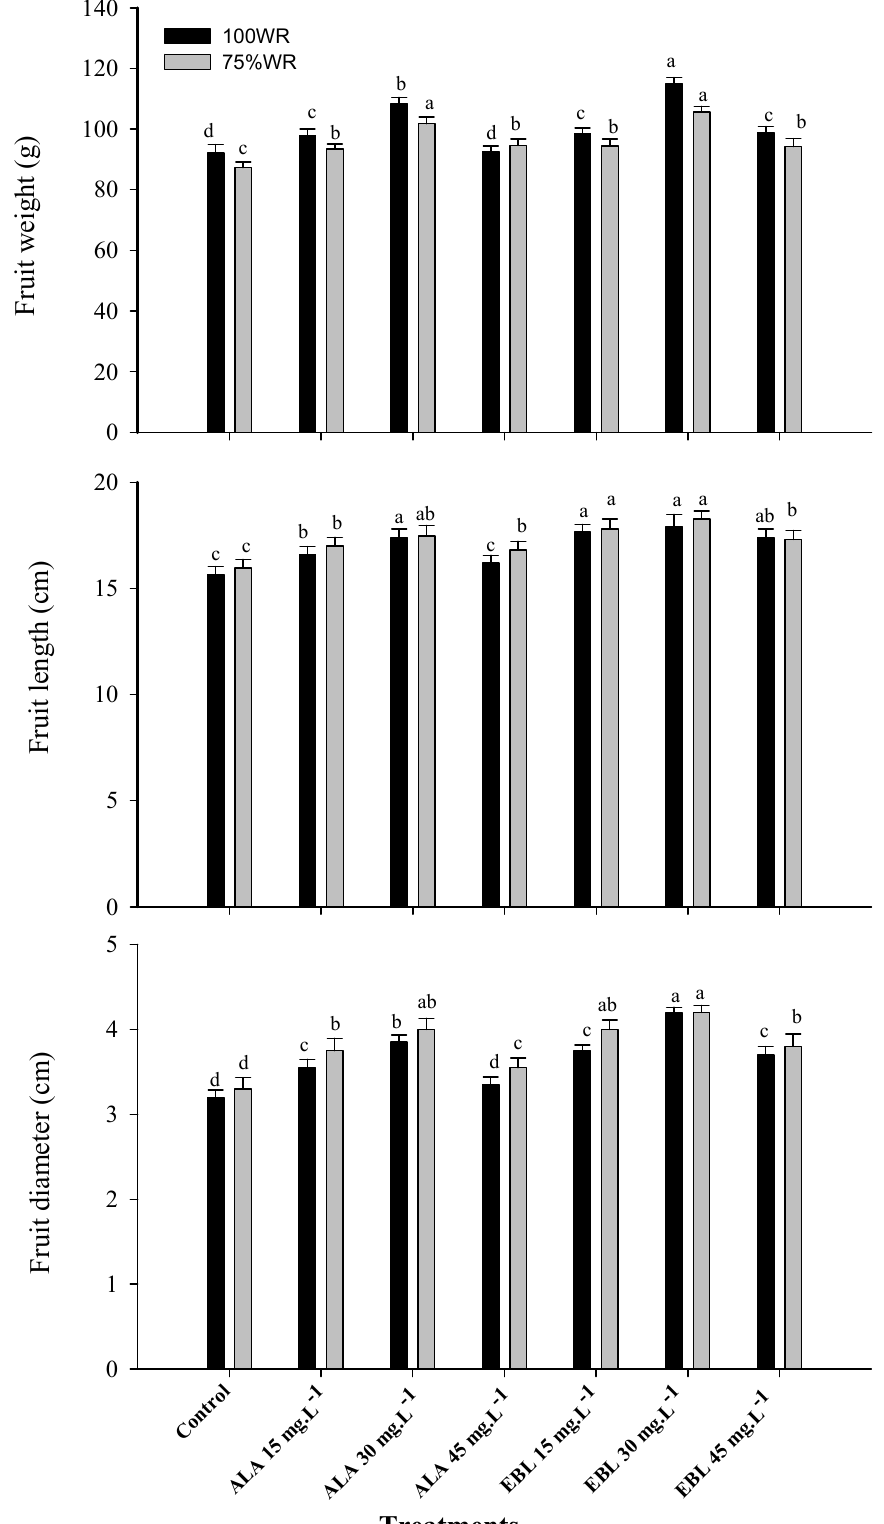
Figure 4. Effect of foliar spray with ALA or EBL on the fruit weight, length, and diameter of drought- stressed “Williams” banana plants during the 2018/2019 and 2019/2020 seasons ( n = 5). The results are the averages of both seasons, and DMRT was used for mean comparisons of treatments under each WR level ( p ≤ 0.05).